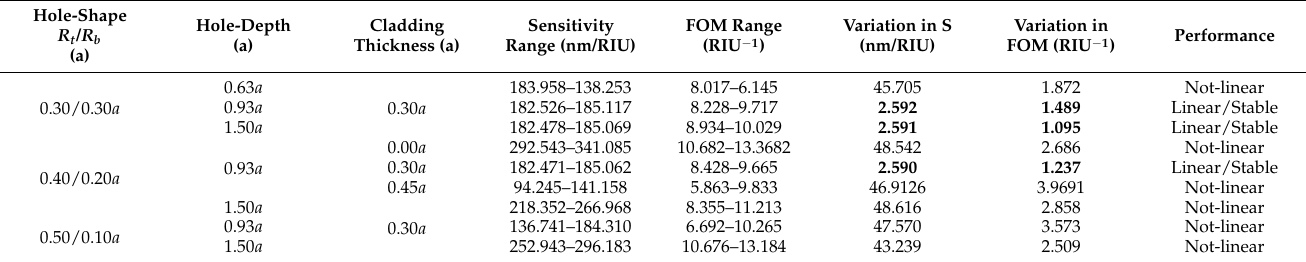
Table 2. Performance comparison of nanosensor devices in terms of S and FOM with respect to variations in their structural parameters.